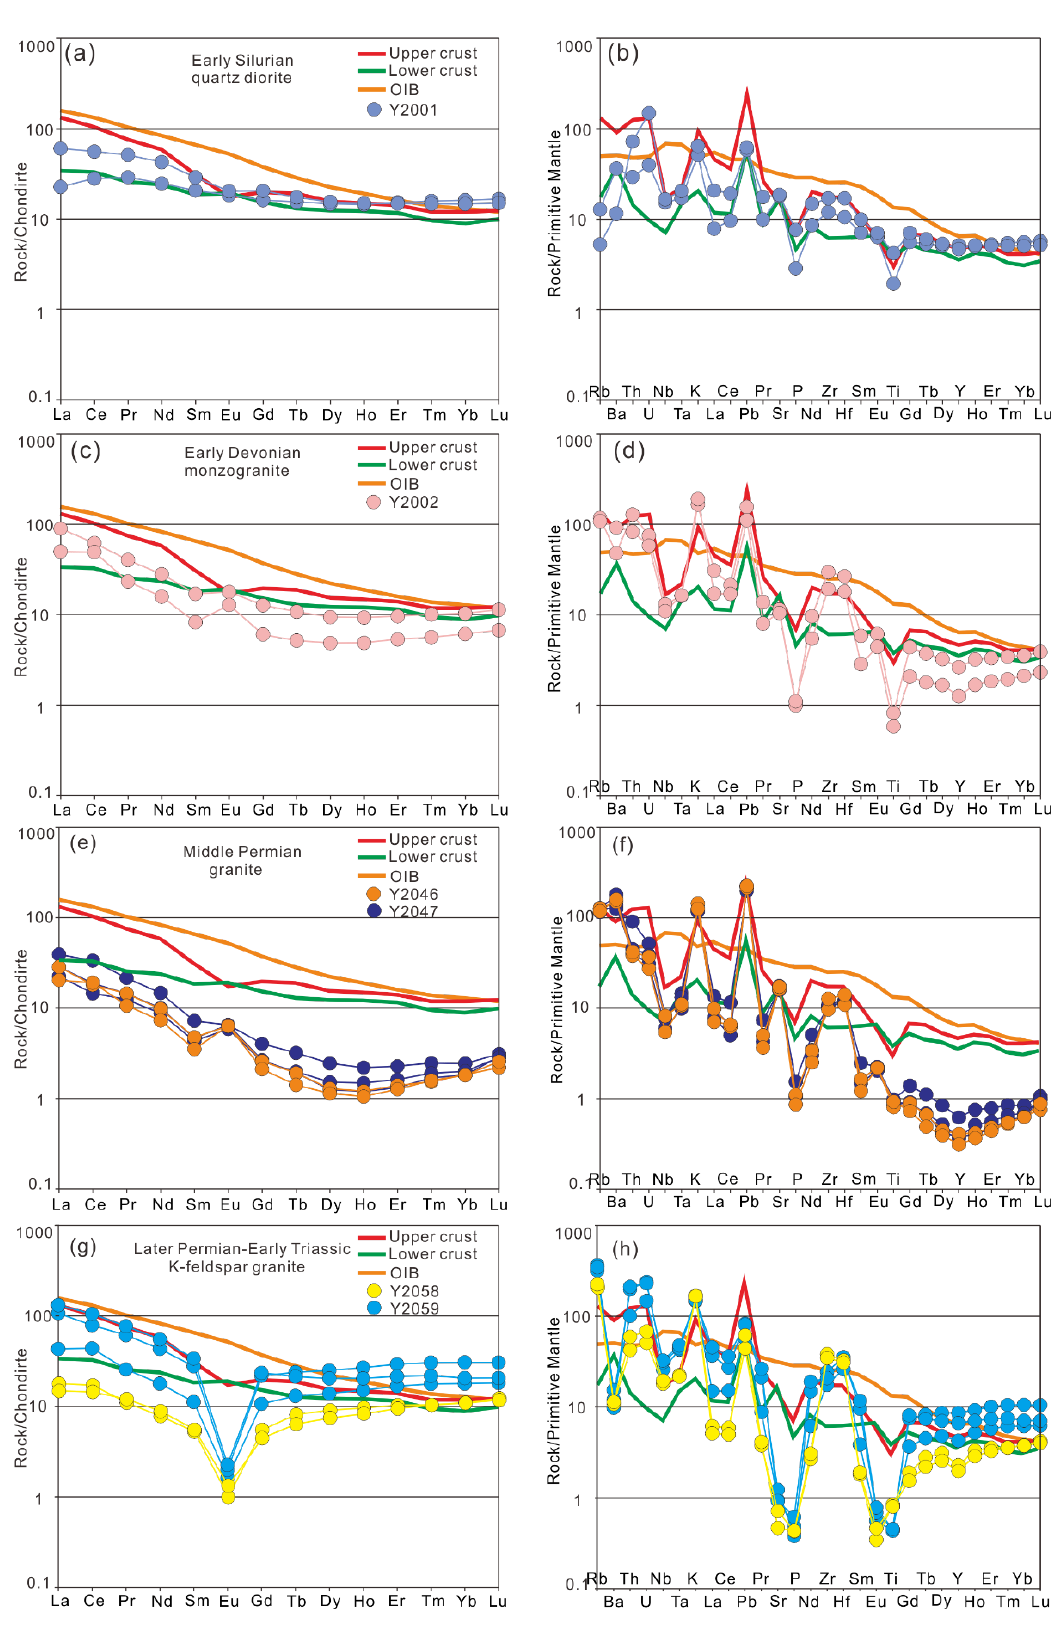
Figure 9. Chondrite-normalized REE patterns ( a , c , e , g ), and primitive mantle-normalized trace elements diagrams ( b , d , f , h ) for the analyzed samples [48,49]. Upper and lower continental crust data are from Ref. [50]; OIB data is from Ref. [49].